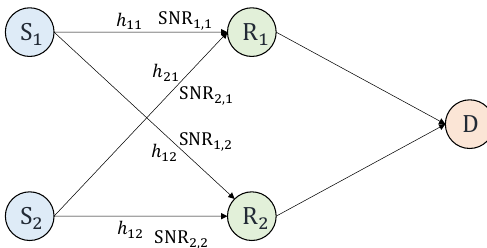
Figure 1. Scenario for the case of a two-source two-relay single-destination network. h kl is the channel coefficient corresponding to the instantaneous received signal-to-noise ratio (SNR) of the link from source k to relay l , where k ∈ { 1,2, · · · , K } and l ∈ { 1,2, · · · , L } . SNR kl denotes the average received SNR of the link from source k to relay l